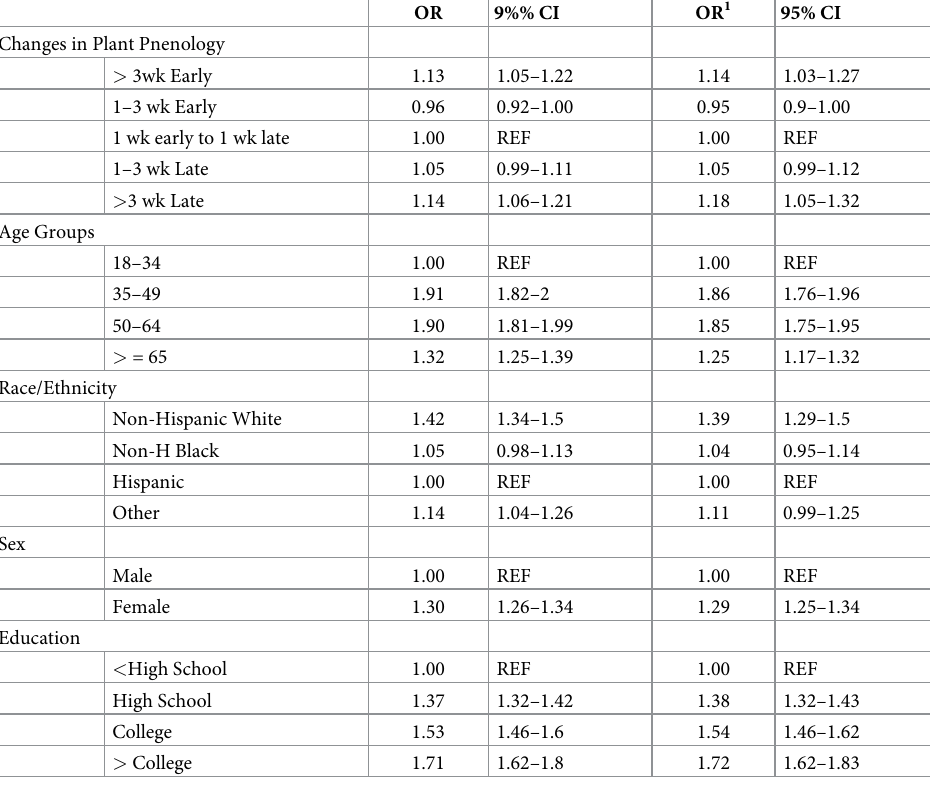
Table 2. Odds Ratios (OR) and 95% Confidence Intervals (CI) for hay fever prevalence among NHIS respondents (2002–2013). OR 9%% CI OR 1 95% CI Changes in Plant